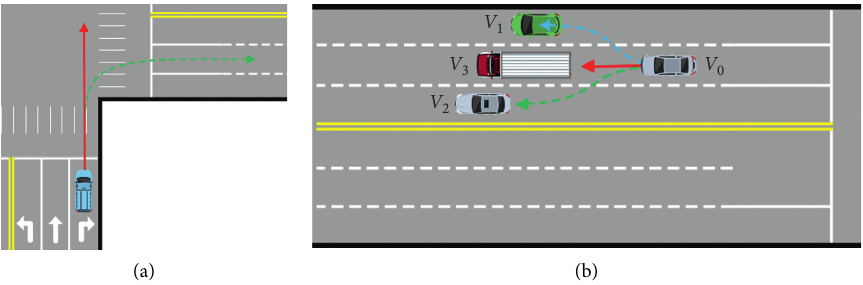
Figure 1: Influence of driving knowledge on trajectory prediction: (a) influence of road structure on trajectory prediction; (b) influence of driving experience on trajectory